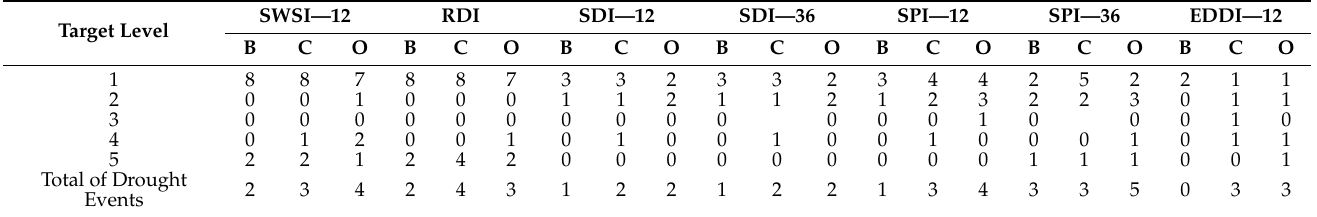
Table 13. Occurrence of drought events according to their severity. B, C, and O represent Banabui ú , Castanh ã o, and Or ó s,